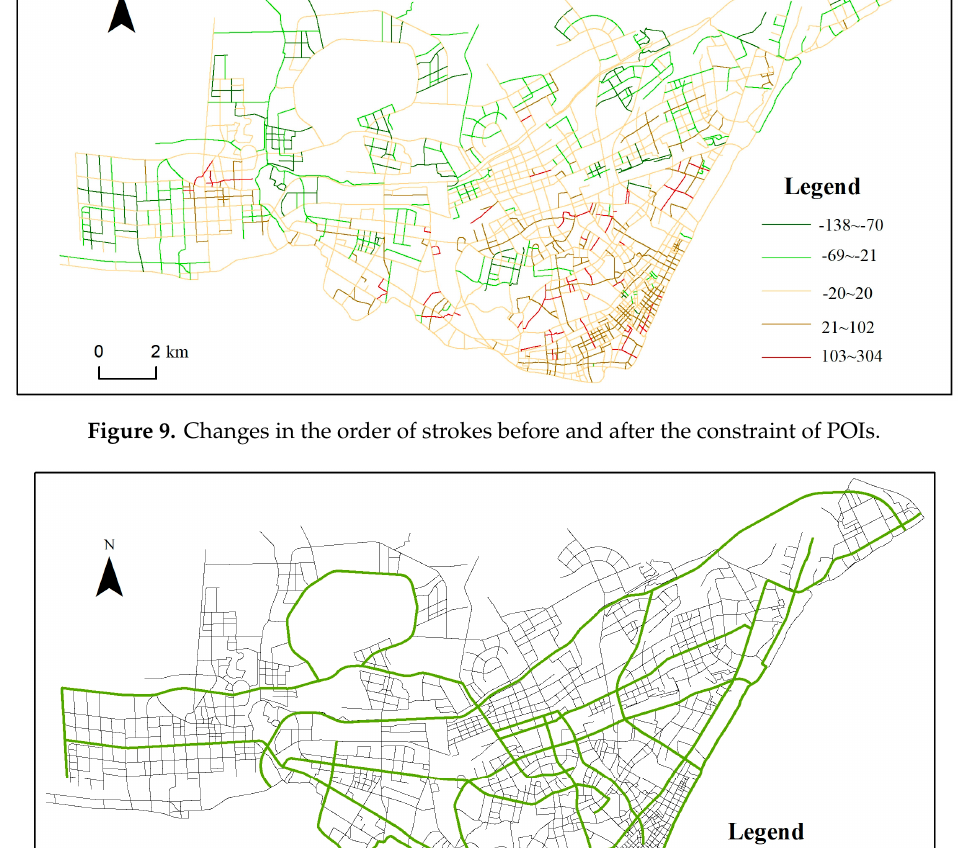
Figure 9. Changes in the order of strokes before and after the constraint of POIs.